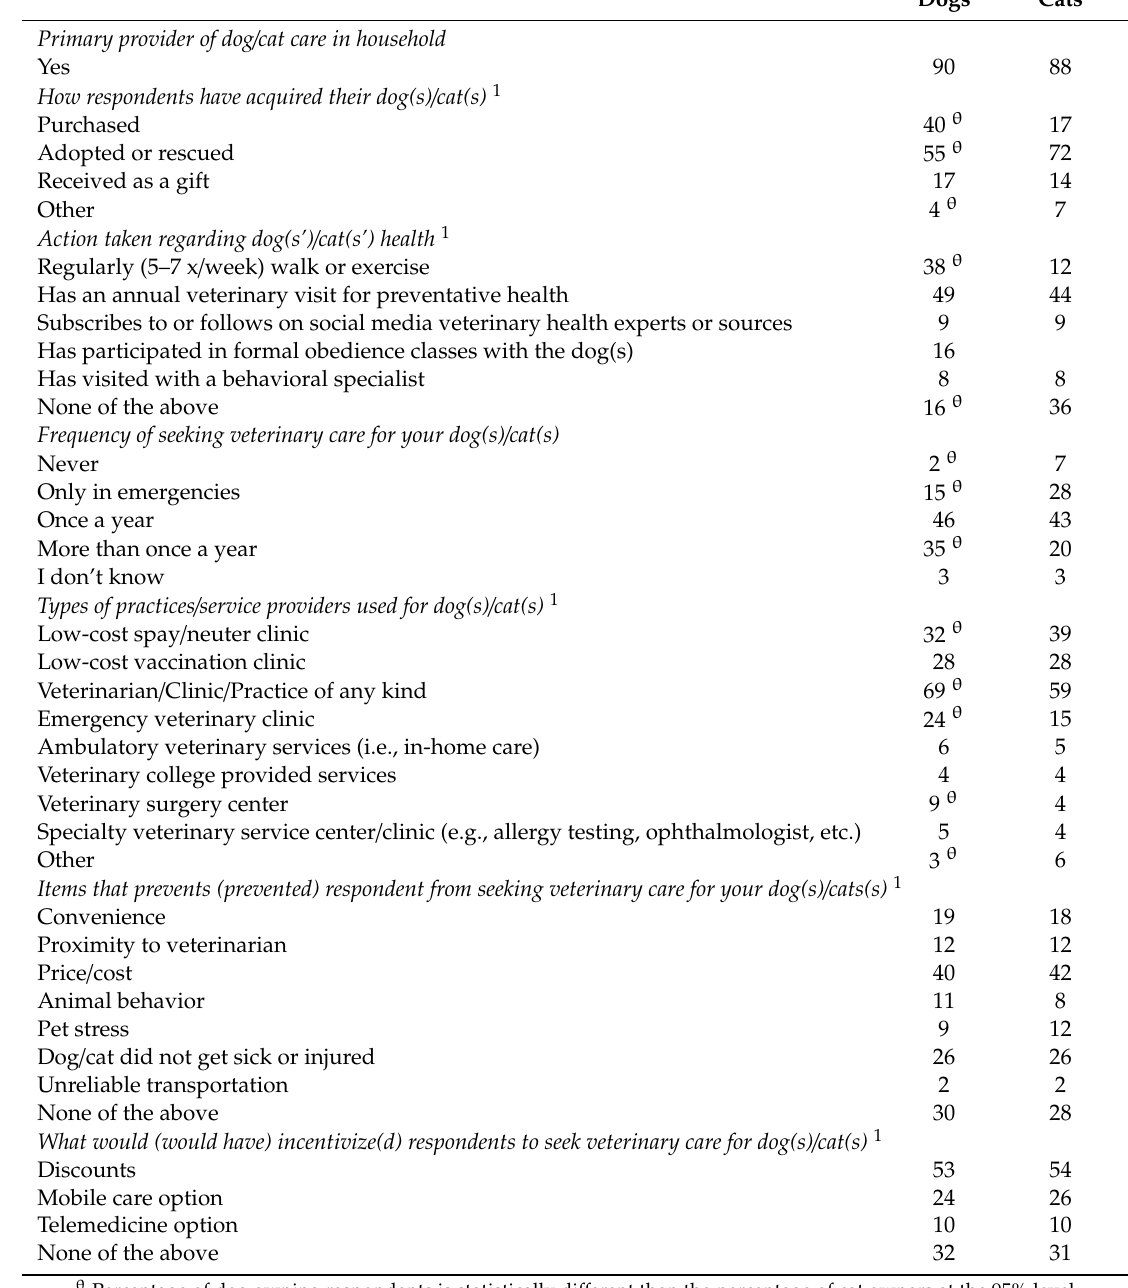
Table 3. Pet owning respondent pet care and usage of veterinary services and statistical comparison between dog and cat owners. Percentage of dog (n = 505) or cat (n = 367) owning respondents.